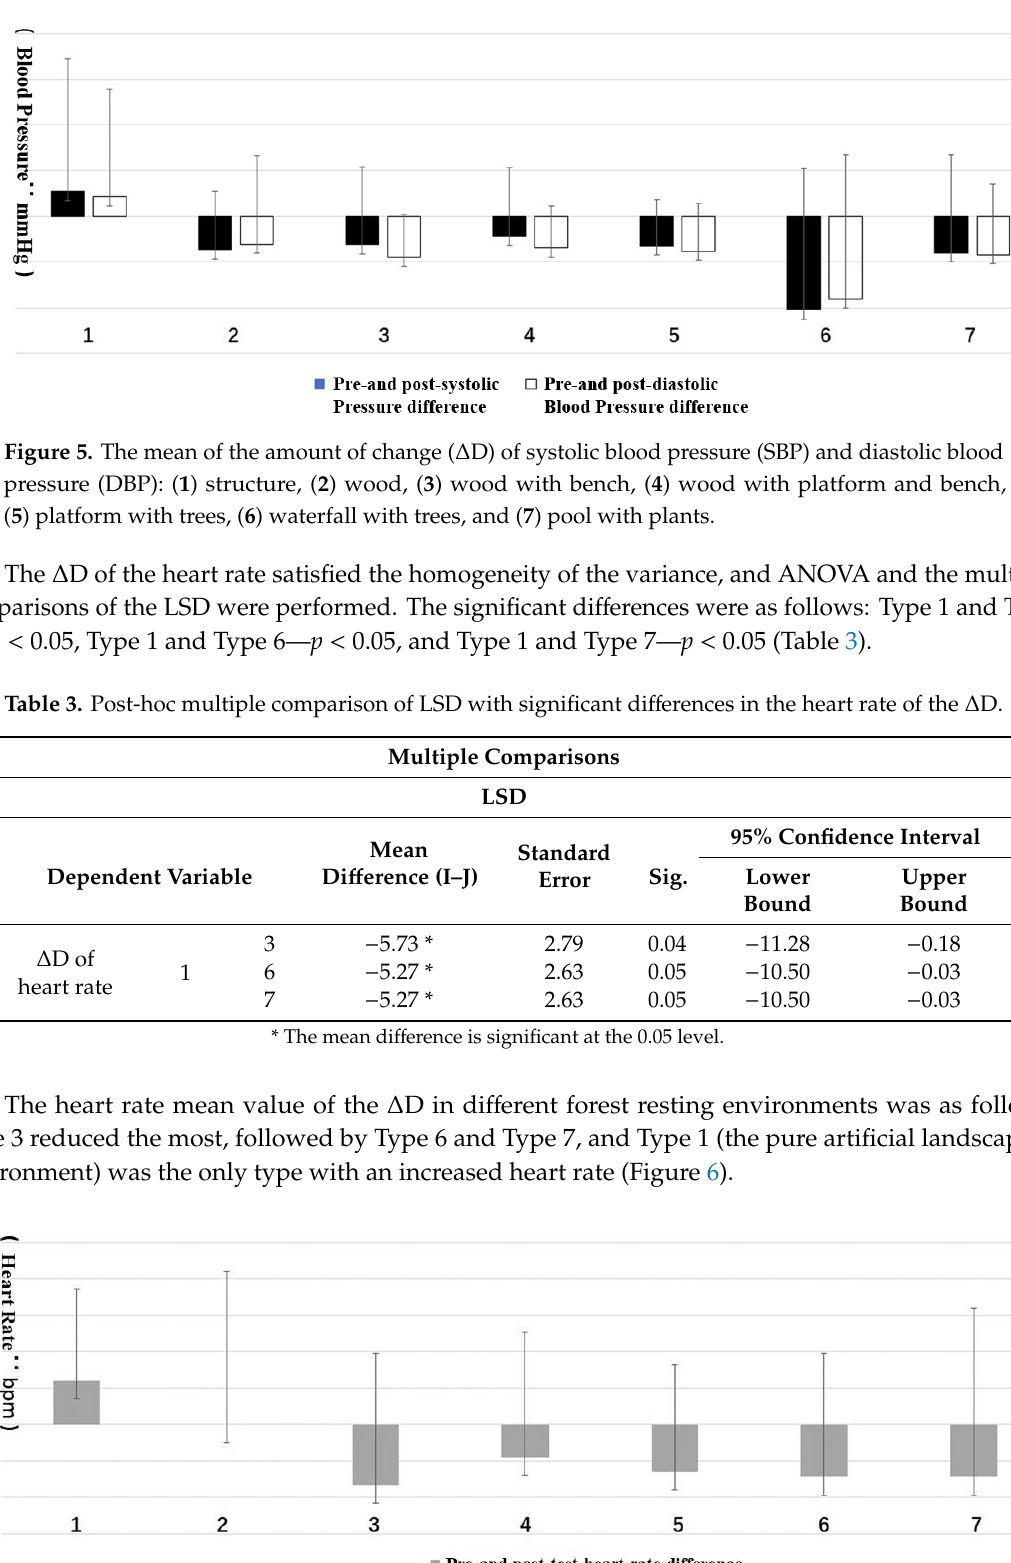
Table 4. Post-hoc multiple comparison of LSD with significant differences in the salivary amylase of the ΔD.